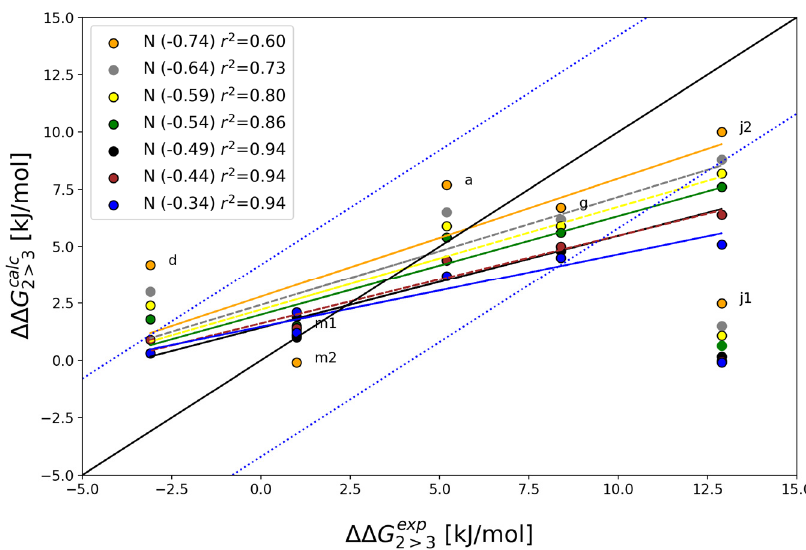
Figure 2. Comparison of experimental vs calculated relative binding a ffi nities between the 2 and 3 . The black diagonal shows perfect agreement between experiment and calculations, the blue dotted lines indicate bounds to ± 4.2 kJ / mol (1 kcal / mol). Regression lines are given for the data set excluding j1. Table 3. Relative Binding Free Energies in kJ / mol between the 2 and 3 Series for Di ff erent Partial Charges on N1.